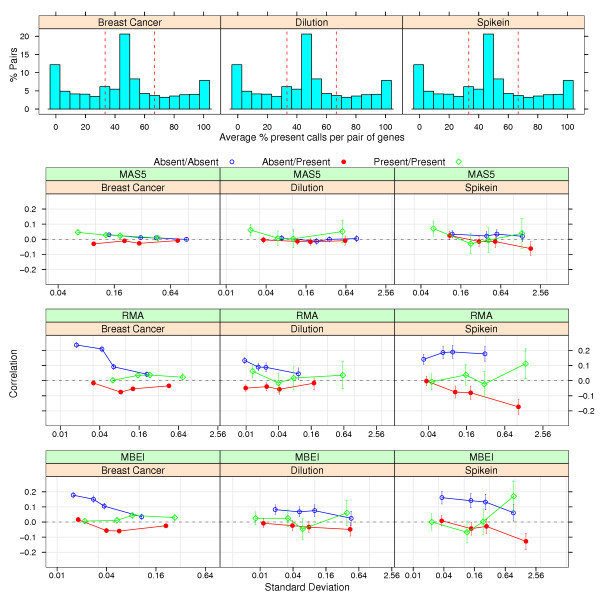
Correlations of randomly sampled pairs of genes by percentage of Affymetrix present calls. Top: Histograms of the average number of present calls for the 5000 pairs of genes, showing three peaks at the ends and in the middle of the range. The red lines seperate the peaks and indicate the grouping of the percentages used in the bottom part of the figure. Looking at Figure 5, we identify the groups with pairs of genes where both genes are mostly absent (left peak), where both genes are mostly present (right peak), and where one gene is mostly absent and the other mostly present (central peak). Bottom: Summary curves for the correlations as a function of the product of standard deviations. The different curves correspond to the three groups of pairs of genes as identified in the histograms above. Note how correlations are consistently positive for absent/absent pairs and consistently negative for absent/present pairs in case of RMA and MBEI. Only the present/present pairs appear to be reasonably uncorrelated throughout.